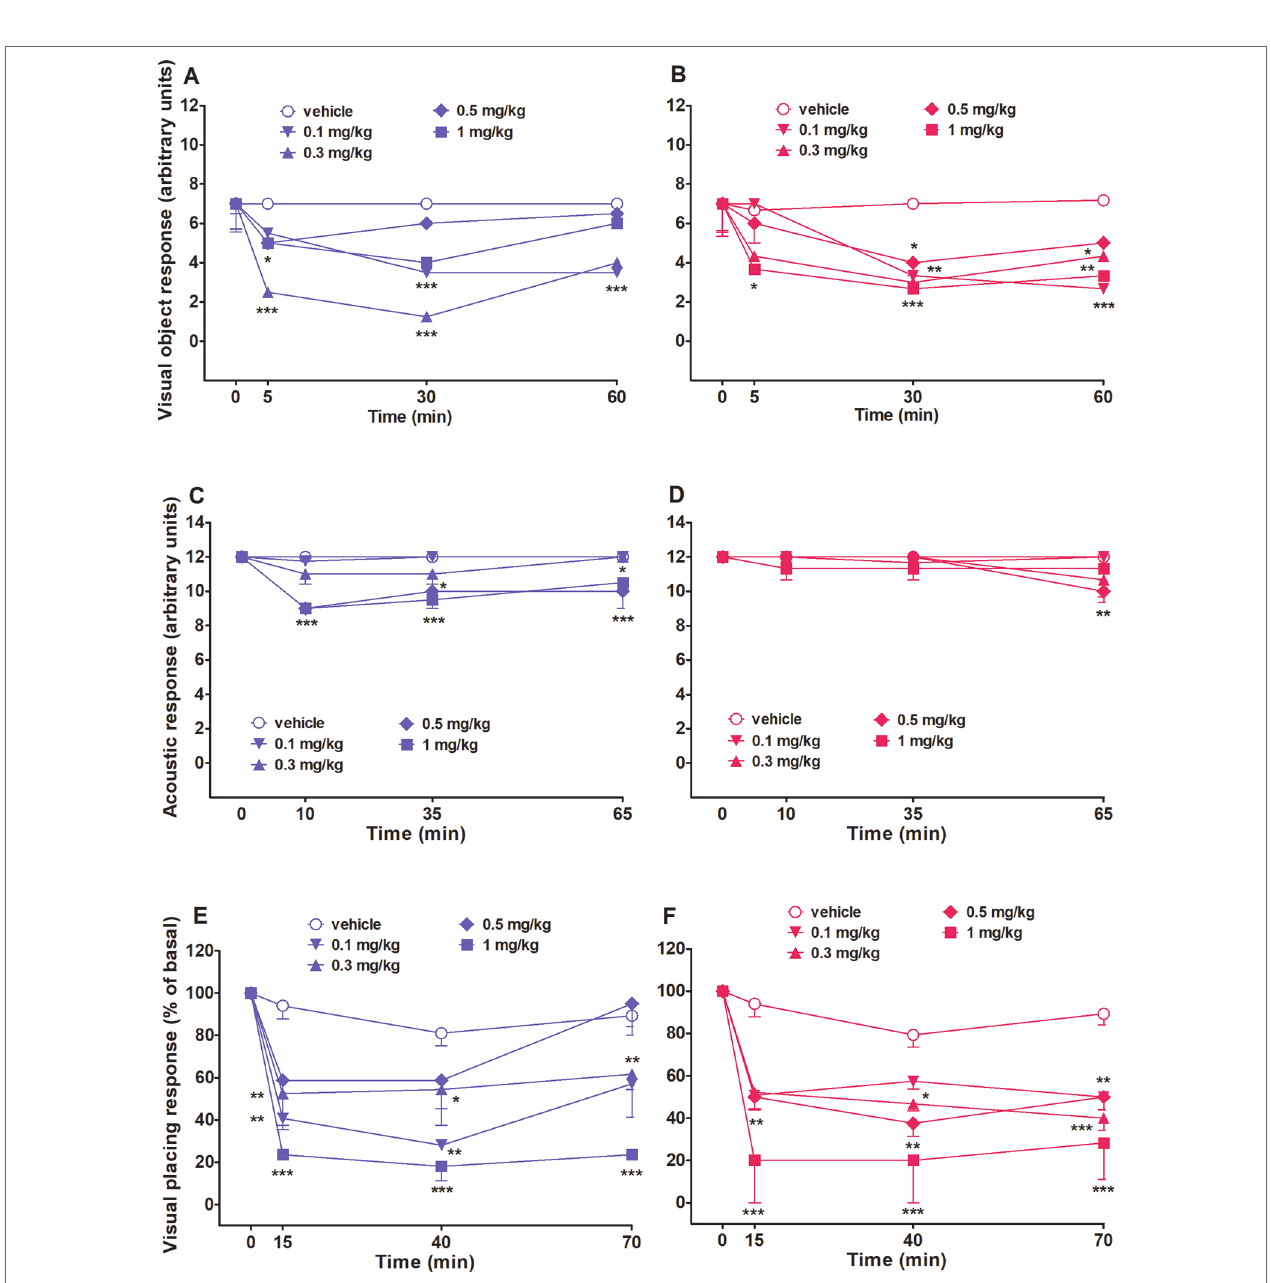
FIgURe 3 | Intraperitoneal injection (0.1–1 mg/kg) of 25I-NBOMe in male and female rats on the visual object test (A and B) , on the acoustic response (c and D) , and on the visual placing test (e and F) . Data are expressed as arbitrary units (A , B , c , and D) or percentage of basal (e and F) and represent the mean ± SEM of six determinations for each treatment. Statistical analysis was performed by two-way ANOVA followed by Bonferroni’s test for multiple comparisons for the dose– response curve at different times. * p < 0.05, ** p < 0.01, *** p < 0.001 versus vehicle.